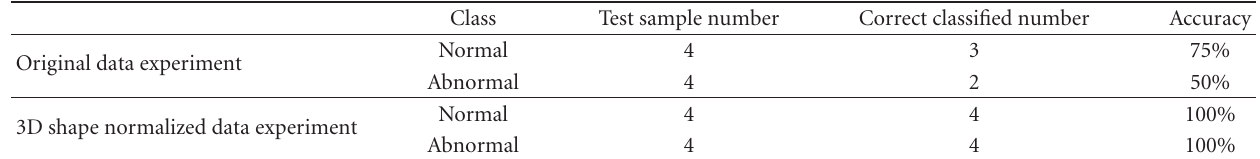
Table 2: Classification